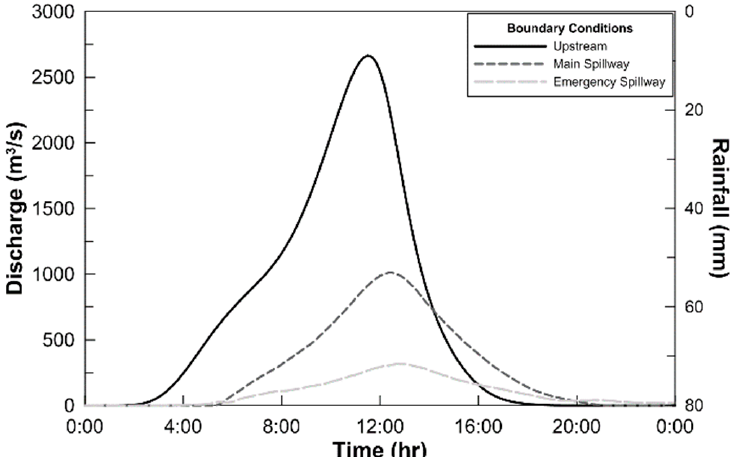
Figure 13. Discharge based on scenario rainfall.